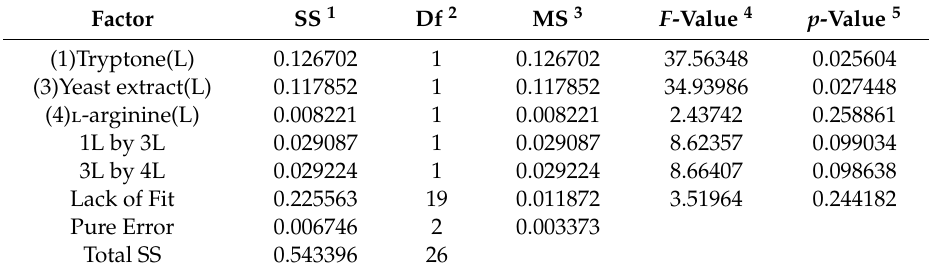
Table 4. Analysis of variance (ANOVA) for central composite rotational design (CCRD) for biomass production of syngas fermentation by Clostridium carboxidivorans after 24 h.